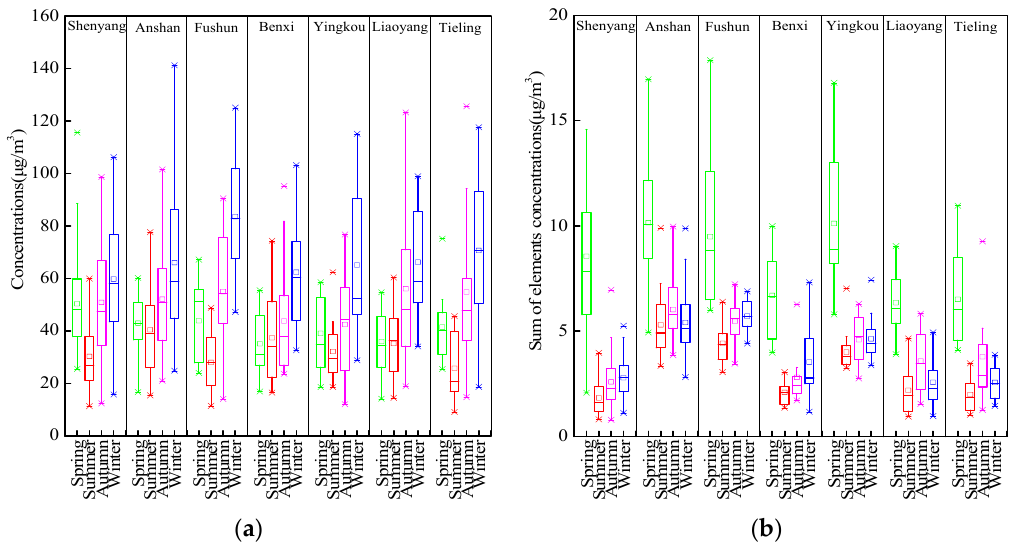
Figure 2. ( a ) The seasonal mean concentrations of PM 2.5 measured at the seven cities. ( b ) The seasonal mean concentrations of the sum of elements in PM 2.5 measured at the seven cities. Shown in each subfigure are the mean (dot symbol), the median (horizontal line), the central 50% data (25th–75th percentiles; box), and the central 90% data (5th–95th percentiles; whiskers).